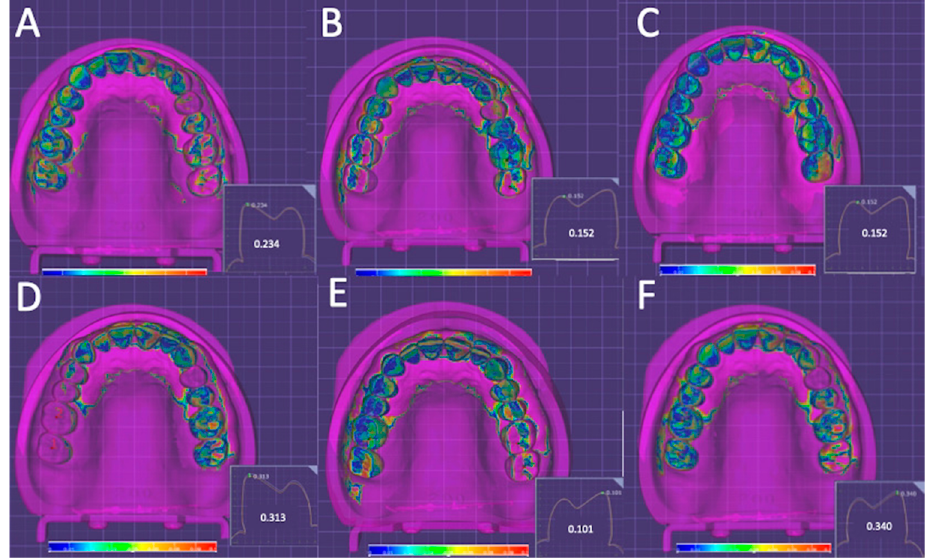
Figure 2. Color code showing deviations for head movement ( A ) Linear, ( B ) Circle, ( C ) Wave, ( D ) 8-, ( E ) S-, and ( F ) A-P scan with the reference model. The occlusal deviation of upper left first premolar compared with the reference model shows the values via CAD software.